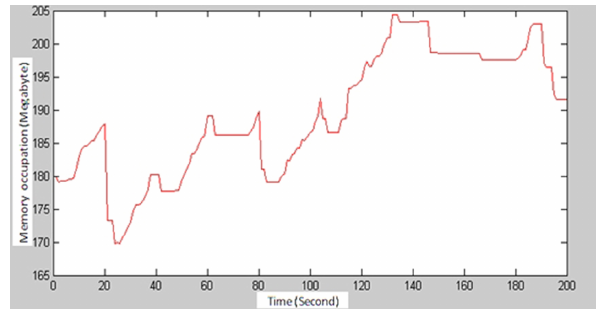
Figure 22. Memory usage (MB) vs. scene time